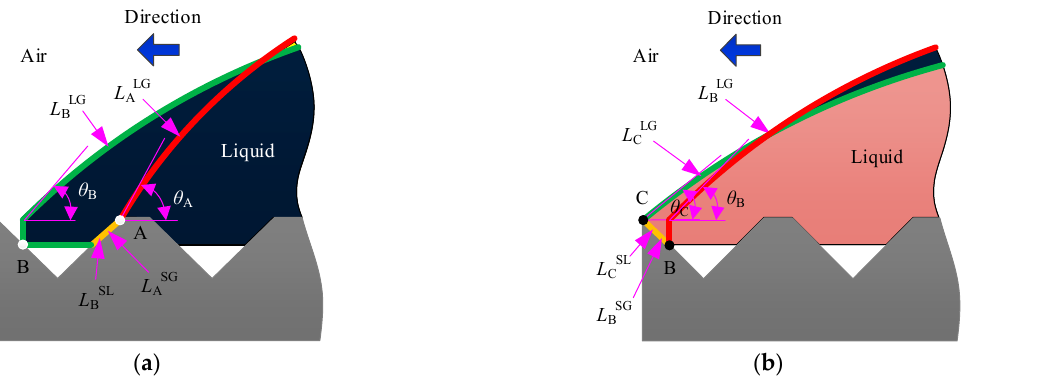
Figure 2. Schematic diagram of the interface changes between the phases of the composite infiltration mode: ( a ) A → B; ( b ) B → C.